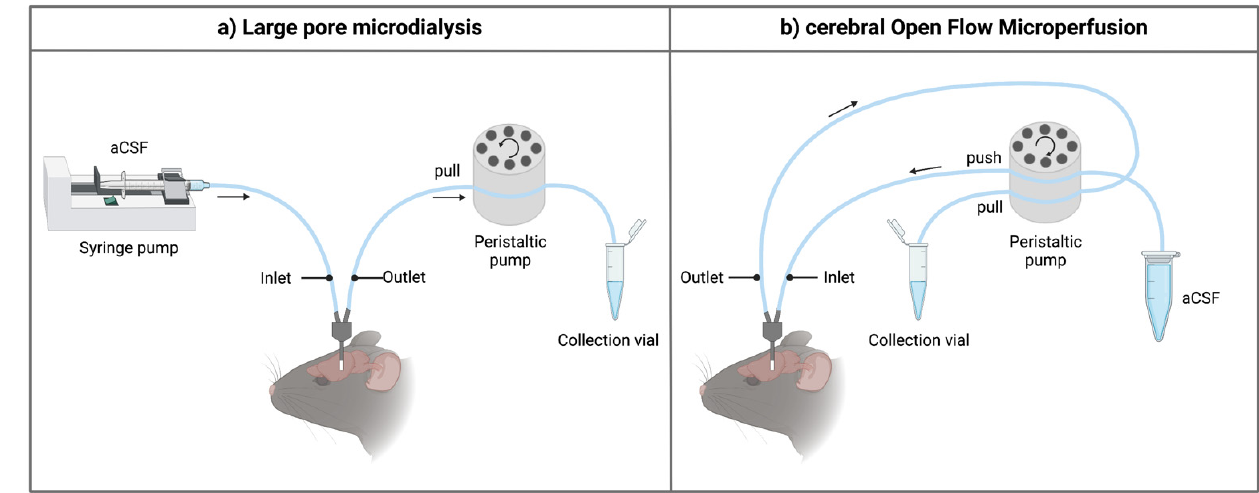
Figure 1. Schematic overview of the inlet and outlet tubings for the sampling techniques. ( a ) When using high-molecular-weight-cut-off microdialysis probes, a push-pull system is required to prevent loss of perfusion fluid through the large pores of the membrane. The setup generally contains a separate controlled pulse-free syringe pump and a peristaltic pull pump (e.g., using an AtmosLM™ or CMA ultra-high cut-off probe). For classical microdialysis, a pull pump is not used. ( b ) For the cerebral open flow microperfusion probe, a peristaltic push-pull microperfusion pump (MPP102 PC, Basi) can be used. Hereby, inflow and outflow can be controlled via the same pump head. Figure created with BioRender.com accessed on 6 April 2022. aCSF: artificial cerebrospinal fluid.